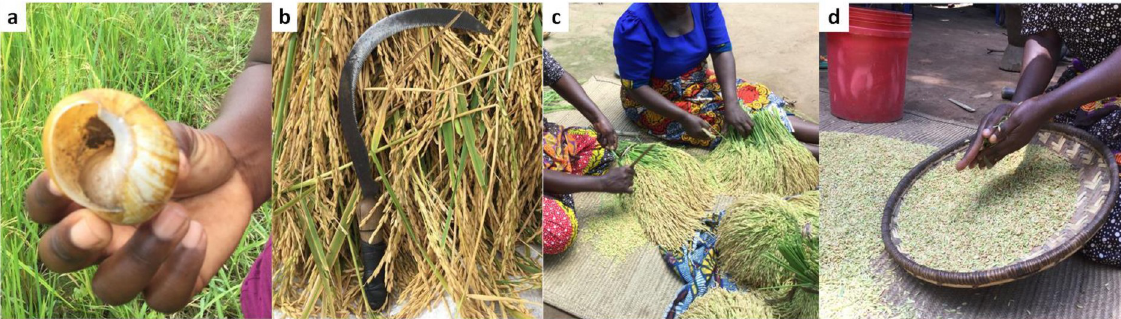
Fig 5. Harvesting of immature paddy rice grains during pepeta production using traditional equipment and methods. a) snail shell, b) sickle placed on harvest rice stalks, c) traditional hand threshing of harvested rice panicles, and d) traditional cleaning (winnowing) of threshed paddy. Survey data, September 2017 –February